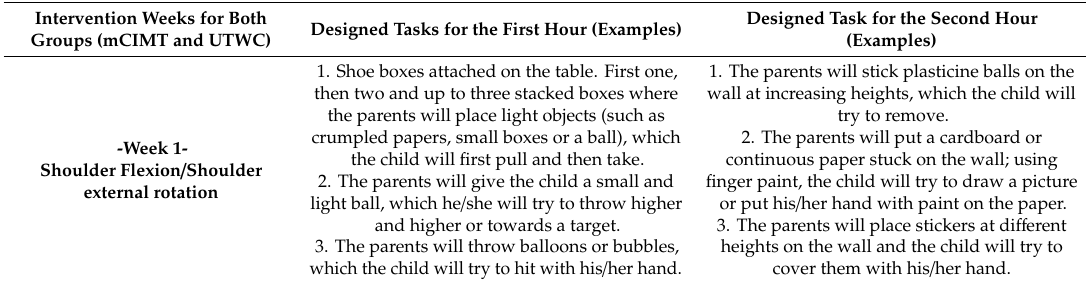
Table A1. Designed task applied in the intervention protocol. Examples of the designed tasks applied in the five week intervention protocol for both therapies (mCIMT and